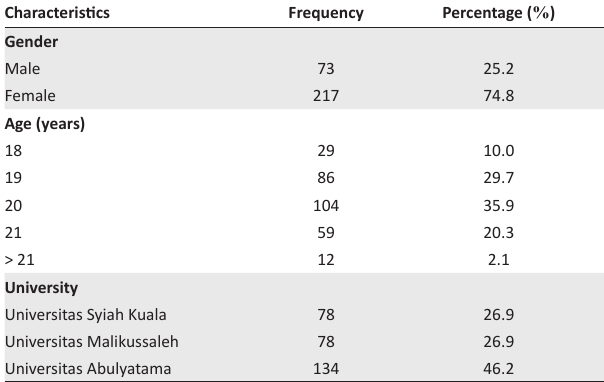
TABLE 2: Demographic characteristics of respondents ( n = 290).